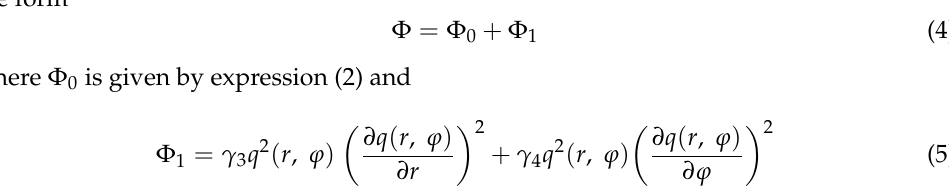
Figure 5. Dynamics of changes in the oscillatory process in time.